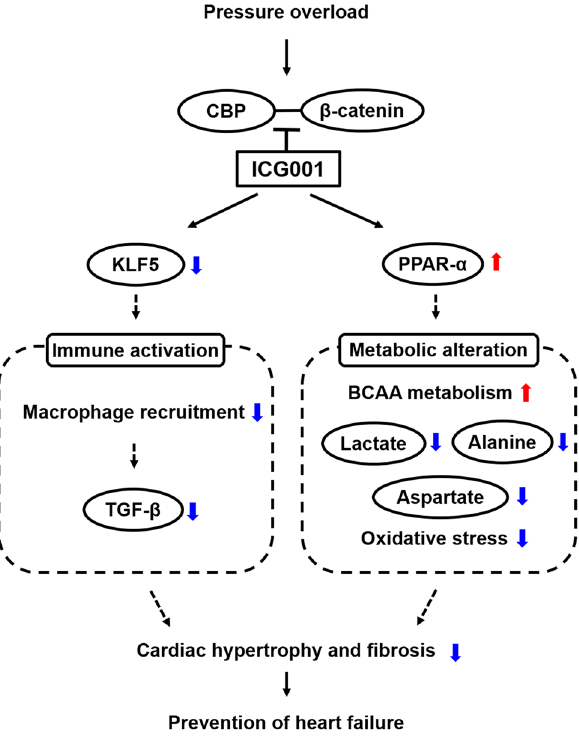
Figure 6. Summary of the proposed pathways of the role of ICG001 to attenuate cardiac hypertrophy and ameliorate cardiac fibrosis induced by pressure overload. ICG001 prevented heart failure induced by pressure overload possibly through two pathways. The dotted lines indicate the hypothesized chain of event. One of the pathways attenuated immune activation mediated by KLF5 upregulation, while the other pathway blocked the PPAR-α downregulation that causes metabolic alteration. ICG001 inhibited the binding of CREB- binding protein (CBP) to β-catenin and then reduced the expression of KLF5 leading to the reduction of macrophage recruitment and TGF-β. Inhibition of CBP and β-catenin complex formation by ICG001 prevented accumulation of lactate, aspartate, and alanine and improved the metabolism of branched-chain amino acid (BCAA). Oxidative stress was reduced by ICG001 according to the ratio of reduced and oxidized glutathione. Both pathways ameliorated cardiac hypertrophy and fibrosis and ultimately prevented